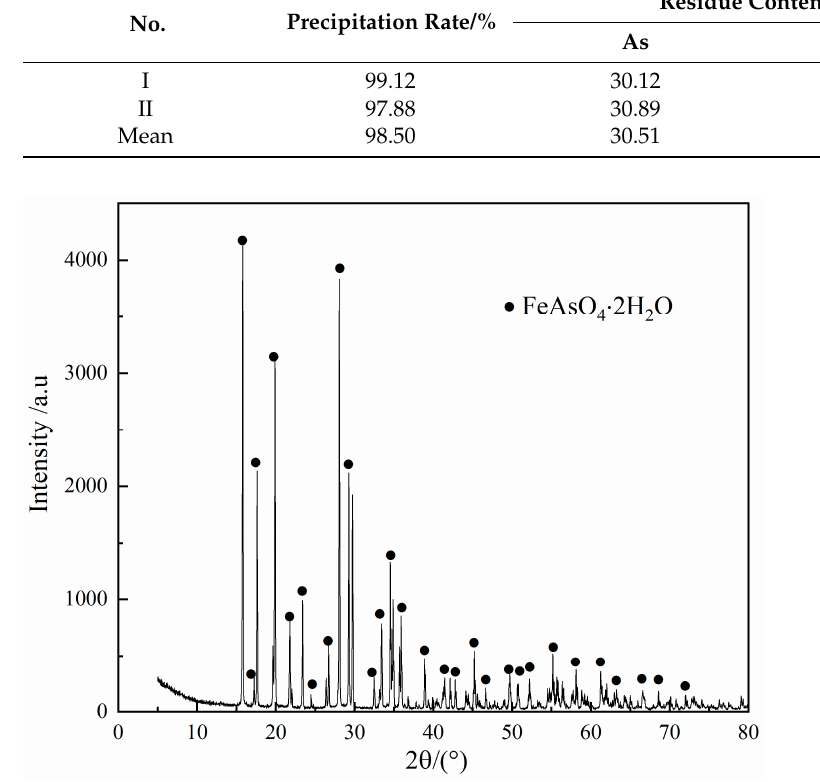
Table 3. Results of verification experiments under optimum conditions.